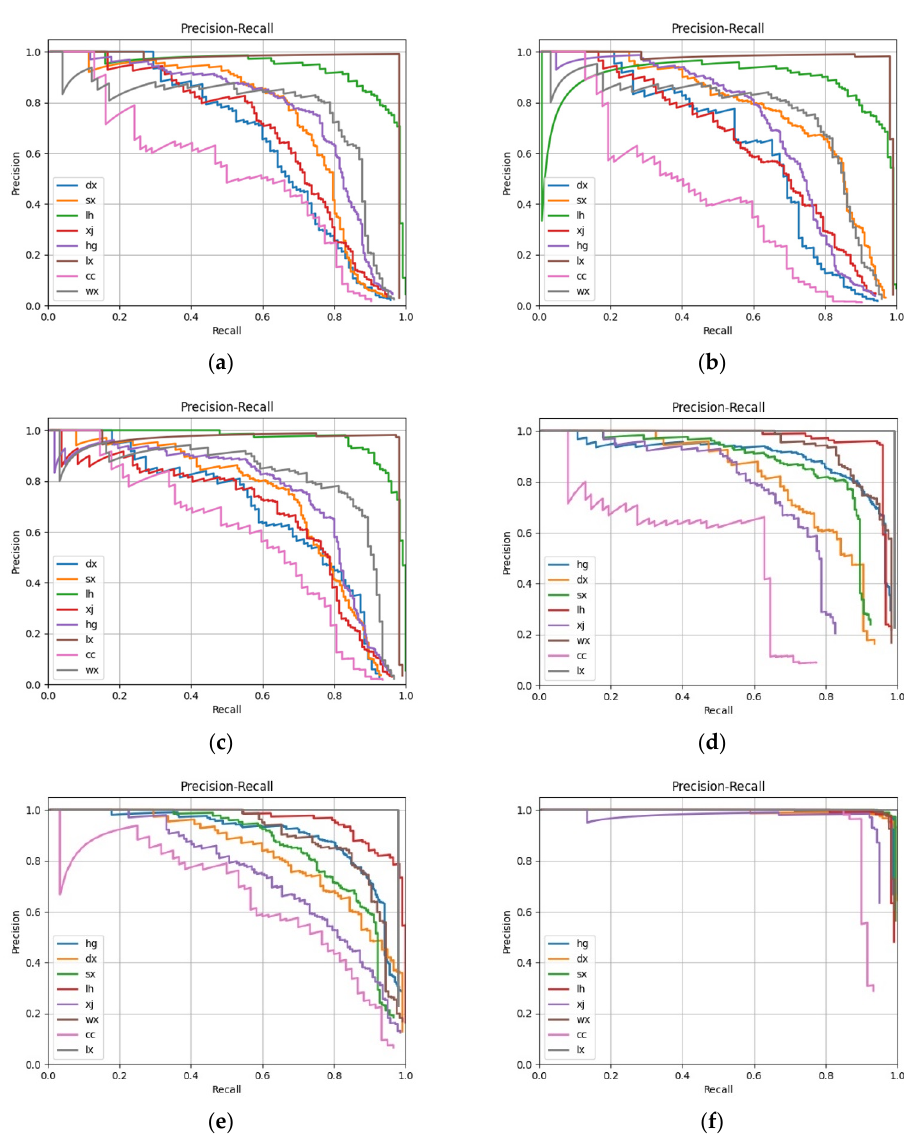
Figure 7. P-R curves of different method in ablation experiment: ( a ) Faster-RCNN; ( b ) YOLO; ( c ) SSD; ( d ) Improved Faster-RCNN; ( e ) FPN; ( f ) multi-scale feature network. Table 3. APs and mAPs of different methods in the ablation experiment.